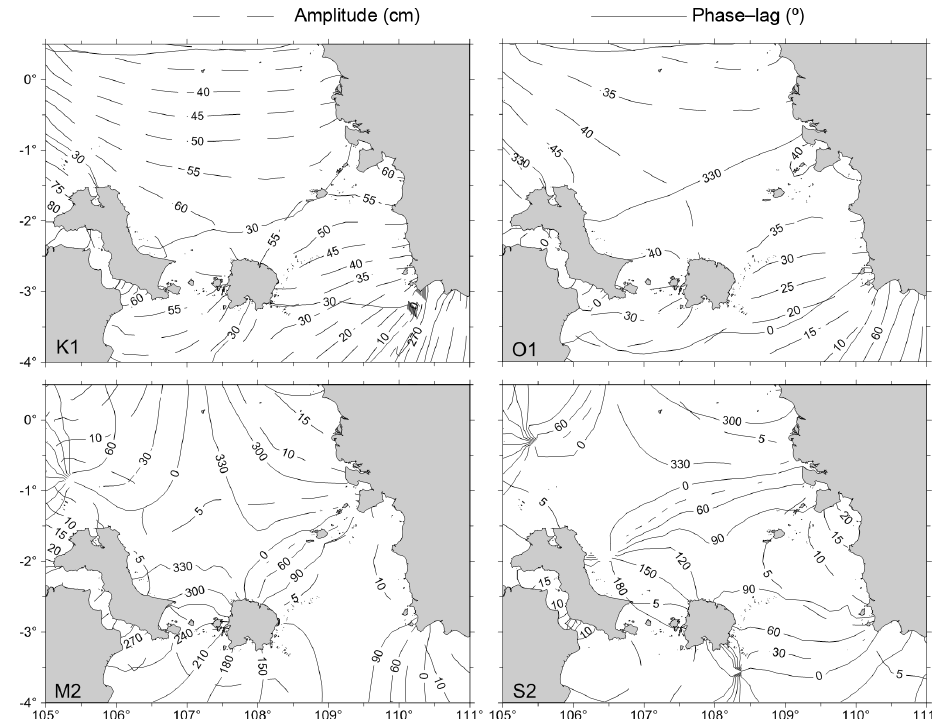
Figure A1. Co-tidal charts for K 1 , O 1 , M 2 and S 2 based on